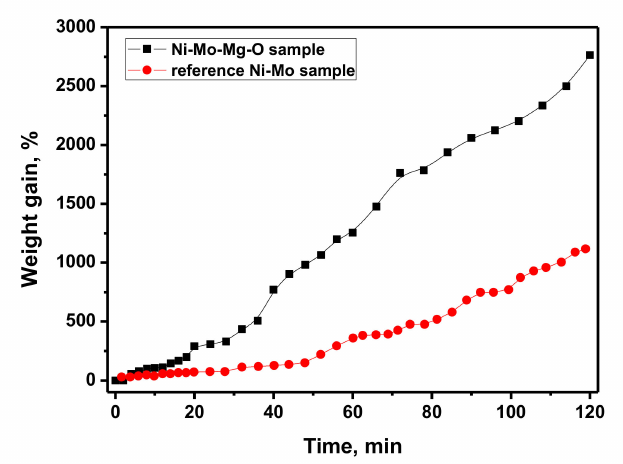
Figure 5. KineticcurvesforthecarbonnanofibersformationduringtheCCVDprocessof